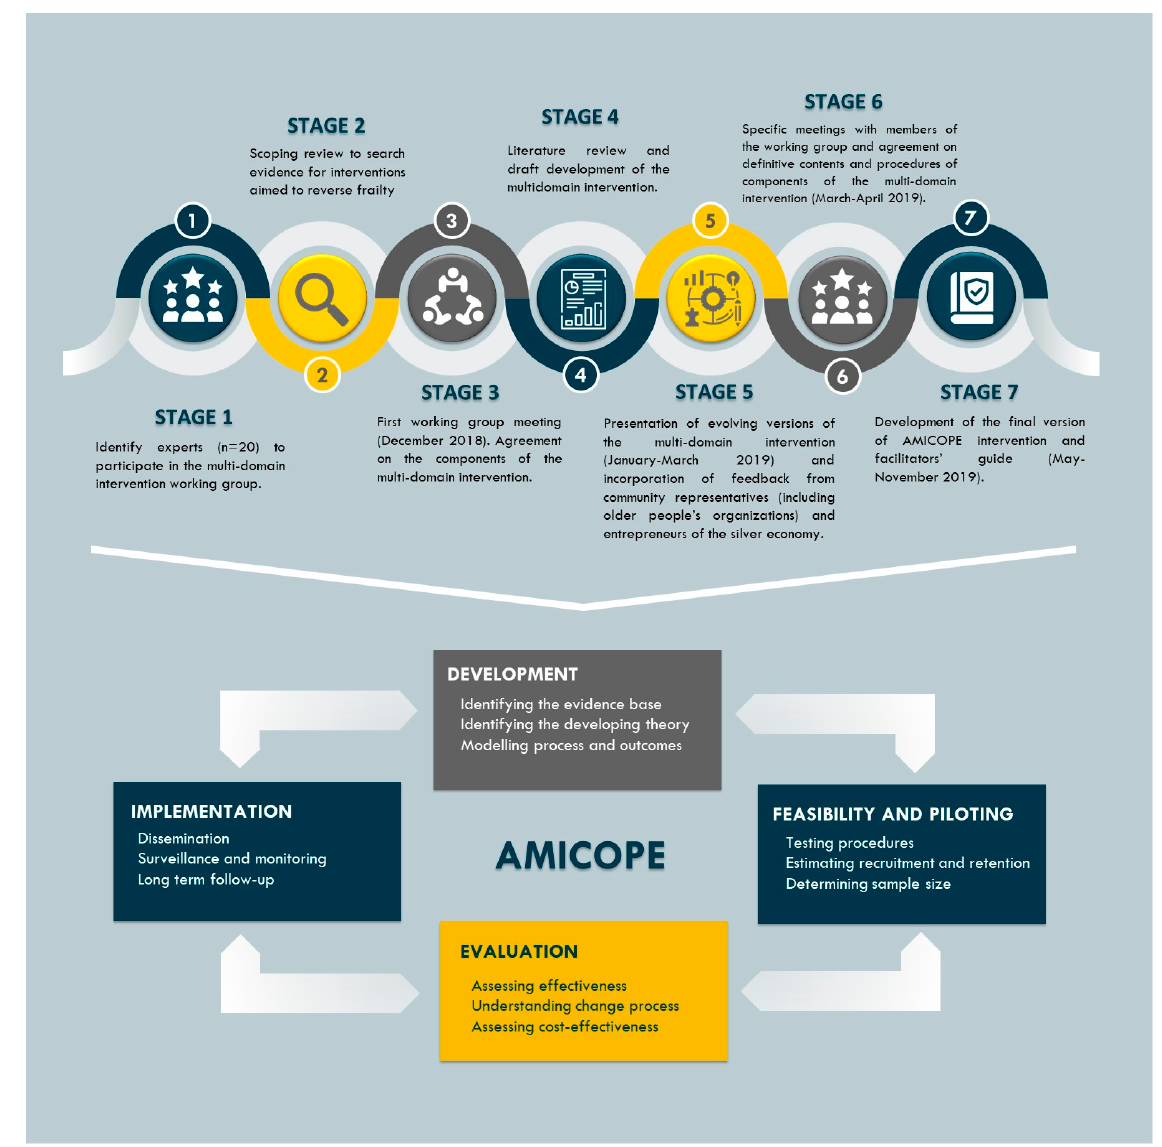
Figure 1. Development process of the AMICOPE intervention within the MRC framework for the development and evaluation of complex interventions. Adapted from [61] and available via license CC BY 4.0